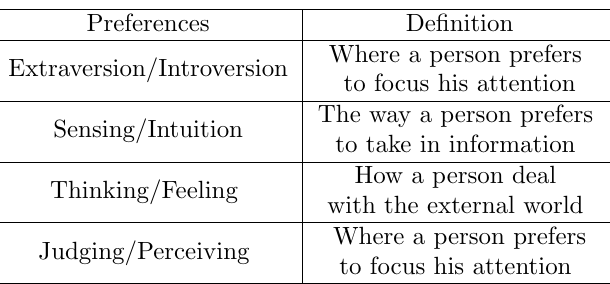
Table 2. Basic four MBTI dimensions